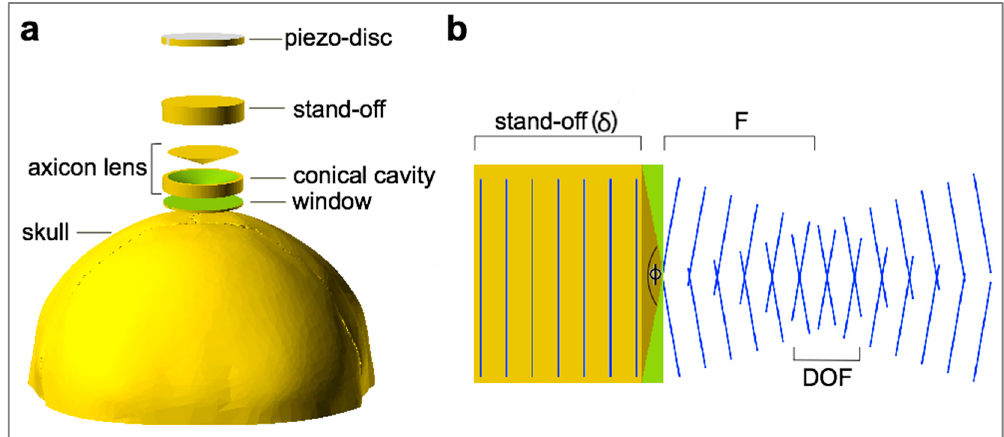
Figure 1. ( a ) Exploded model of the axicon lens. The polydimethylsiloxane (PDMS) fills the conical cavity of the lens and the stand-off. An ultrasonic lens is formed by the PDMS/plastic interfaces. The window is a thin material layer between the conical cavity and the face of the lens; ( b ) schematic ultrasonic beam pattern for transducers with axicon lenses. These are described by its total included cone angle ( φ ). Depth of focus (DOF) is the focal region and F is the desired focal length. Both DOF and F depend on the sound velocity into the material used for the interface.